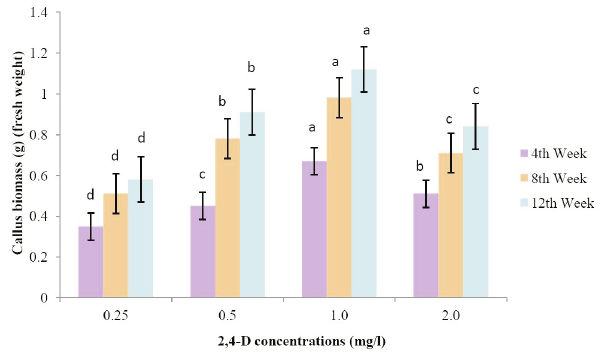
Fig. 2 - Callus biomass growth on MS medium, added with various concentrations of 2, 4-D. Values are means ± standard deviation of three replicates. Within each bar, means followed by the letter, are not significantly different at p≤0.05 according to DMRT.